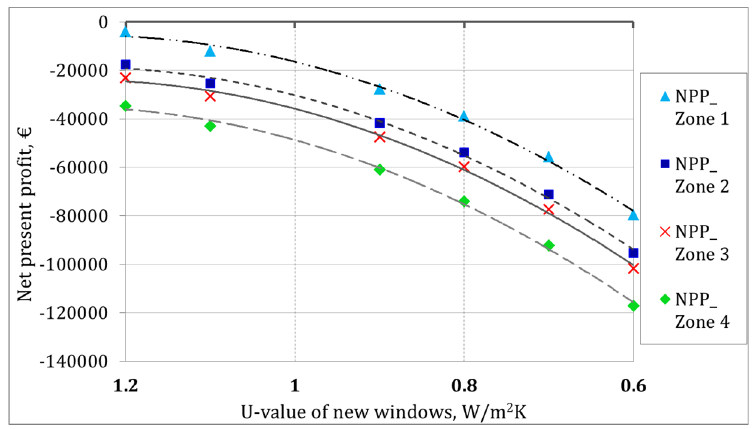
Figure 14. Net present profit of new windows with more efficient windows for the base case scenario.